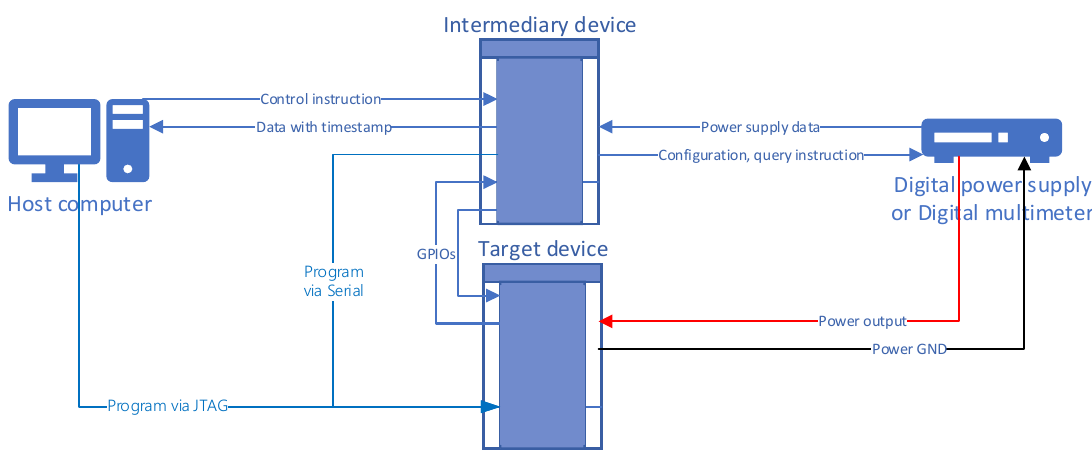
Figure 4. Connection diagram of the measuring platform.